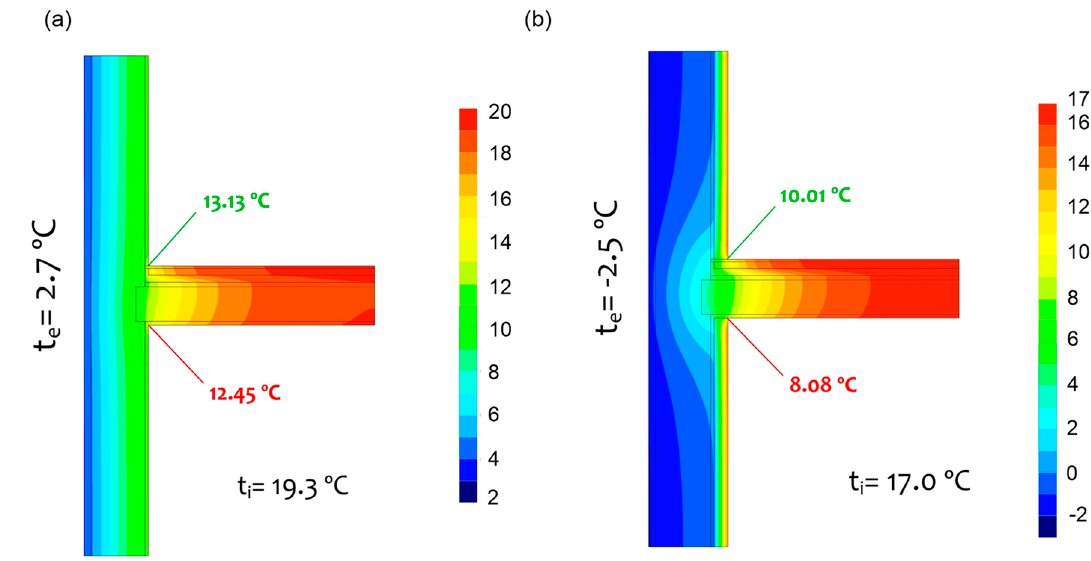
Figure 12. Simulated temperature distribution of the connection of outer walls: ( a ) simulations without thermal insulation; ( b ) simulations with thermal insulation.